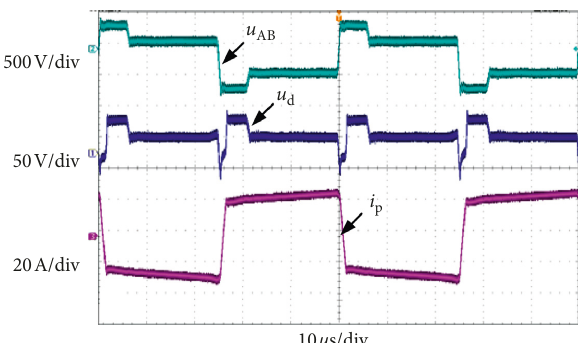
Figure 23: Circuit testing efficiency.